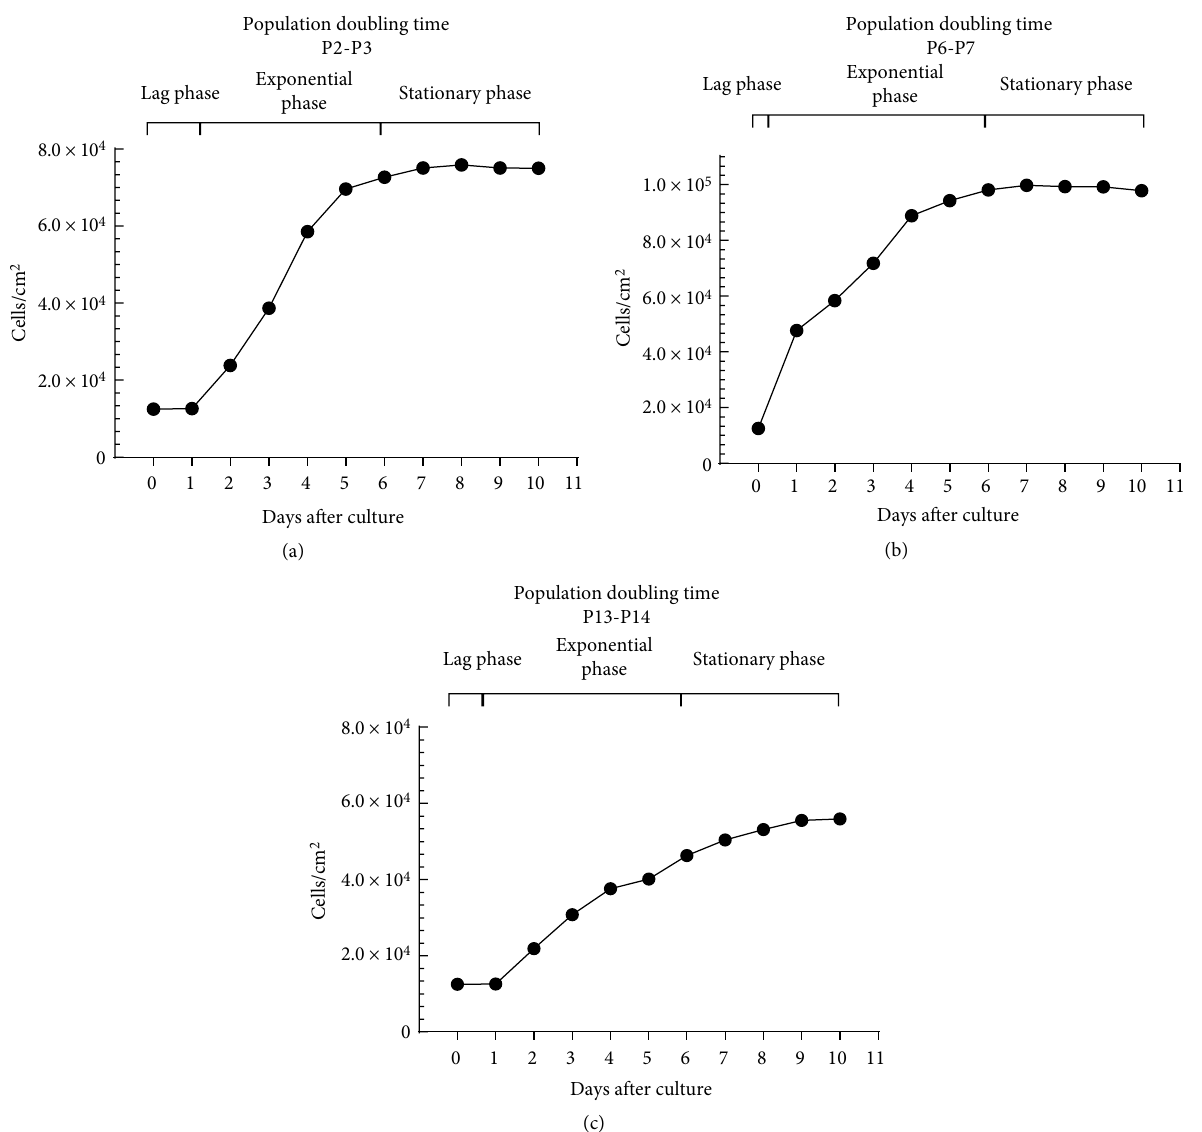
Figure 3: Cell growth of OM-MSCs over 10 days of culture in P2-P3 (a), P6-P7 (b), and P13-P14 (c).